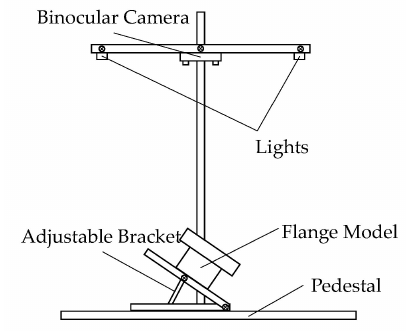
Figure 17. The schematic diagram of measurement angle accuracy verification experiment.